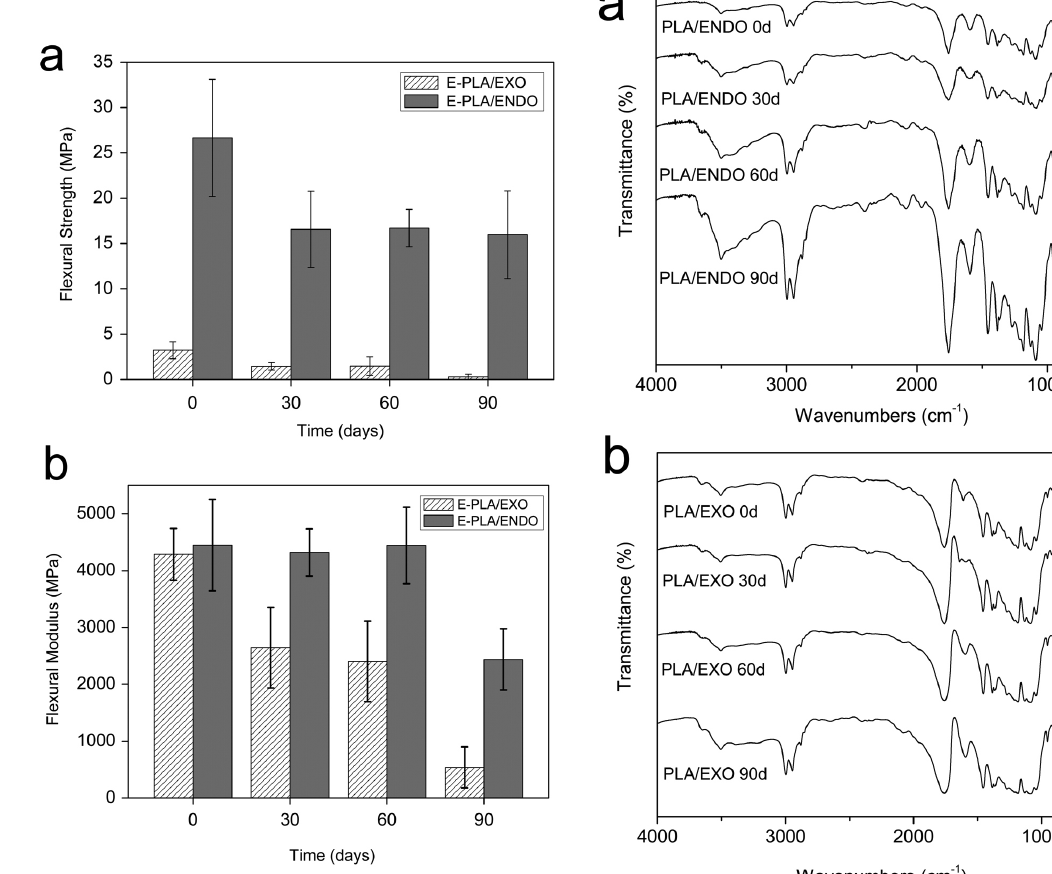
Figure 3. Flexural strength (a) and flexural modulus (b) of E-PLA/ EXO and E-PLA/ENDO samples after 0, 30, 60 and 90 days in simulated soil.